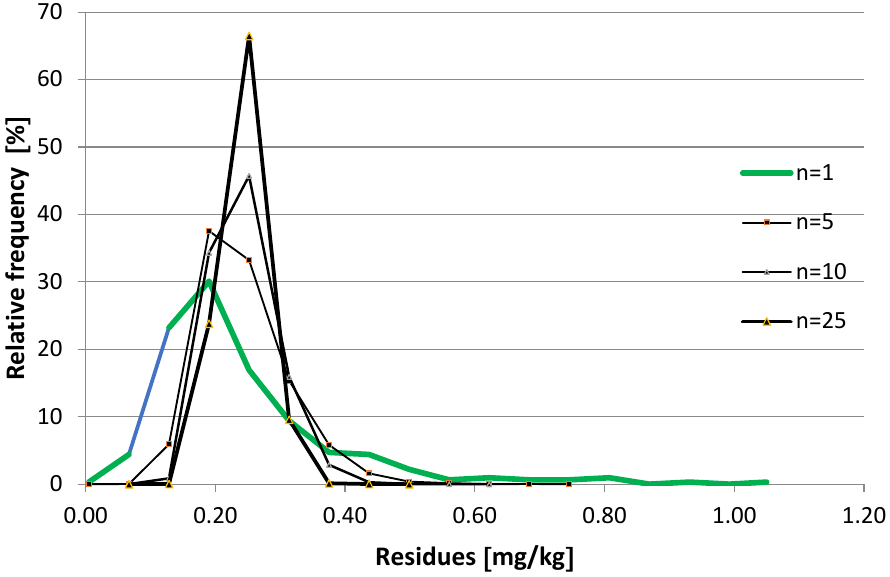
Figure 2. Relative frequency distribution of chlorpyrifos-methyl residues in apples 1 day after the pesticide treatment. Notes: sample size is indicated with ‘n’. 1 for primary samples (single apple) n = 10 is a composite sample consisting of 10 apples. Sampling standards require a composite sample of size 10 for testing compliance with MRLs [8], sample size 25 often collected in supervised field trials [43].